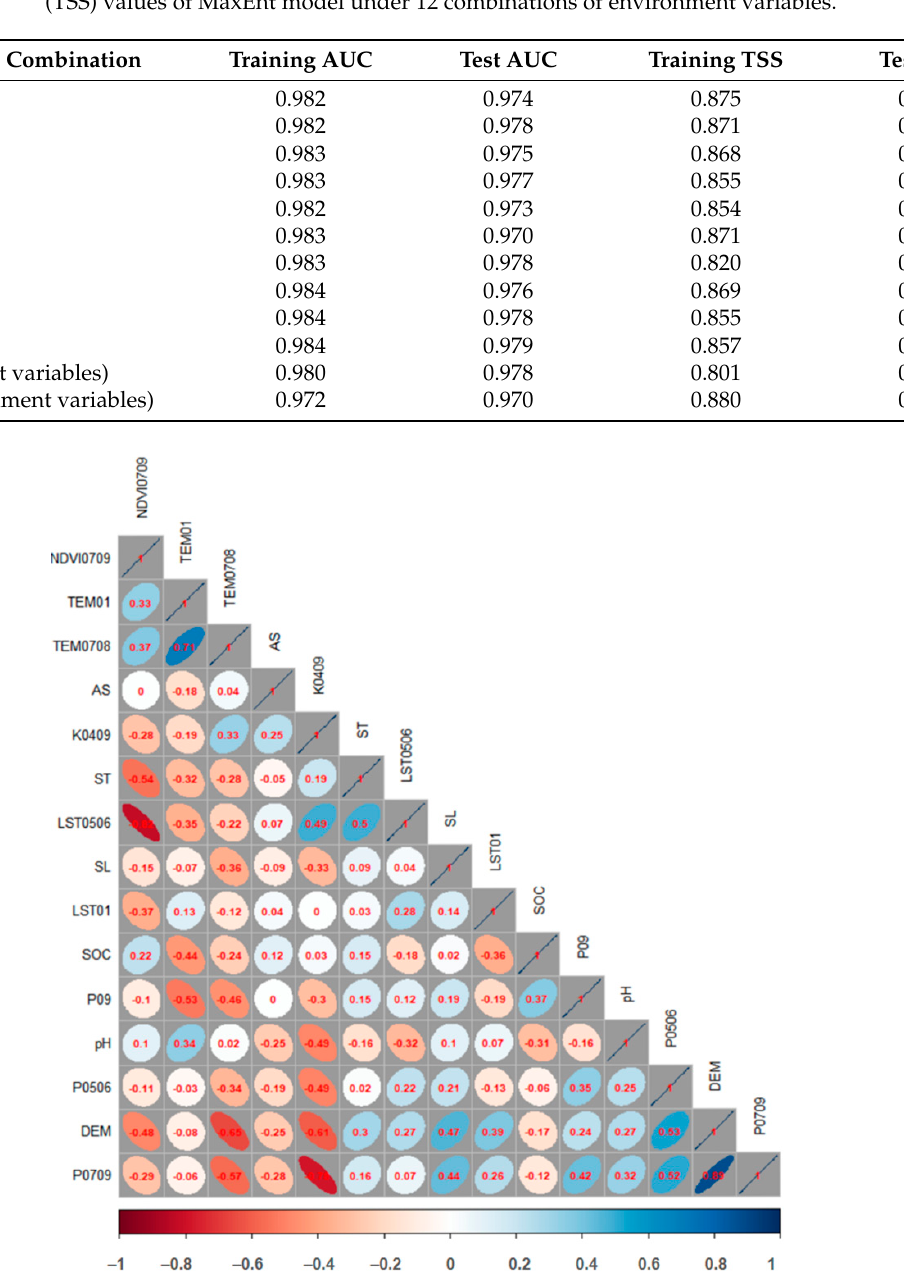
Table 3. The areas under the receiver operating characteristic curve (AUC) and true skill statistic (TSS) values of MaxEnt model under 12 combinations of environment variables.